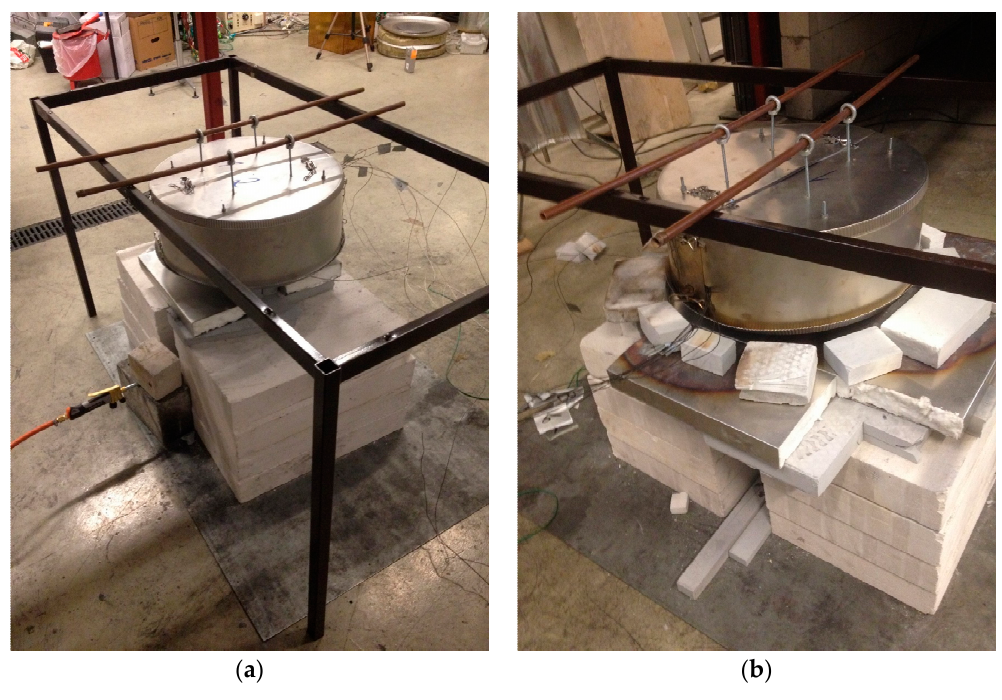
Figure 8. Ready for fire testing; ( a ) Test 1 and ( b ) Test 2.